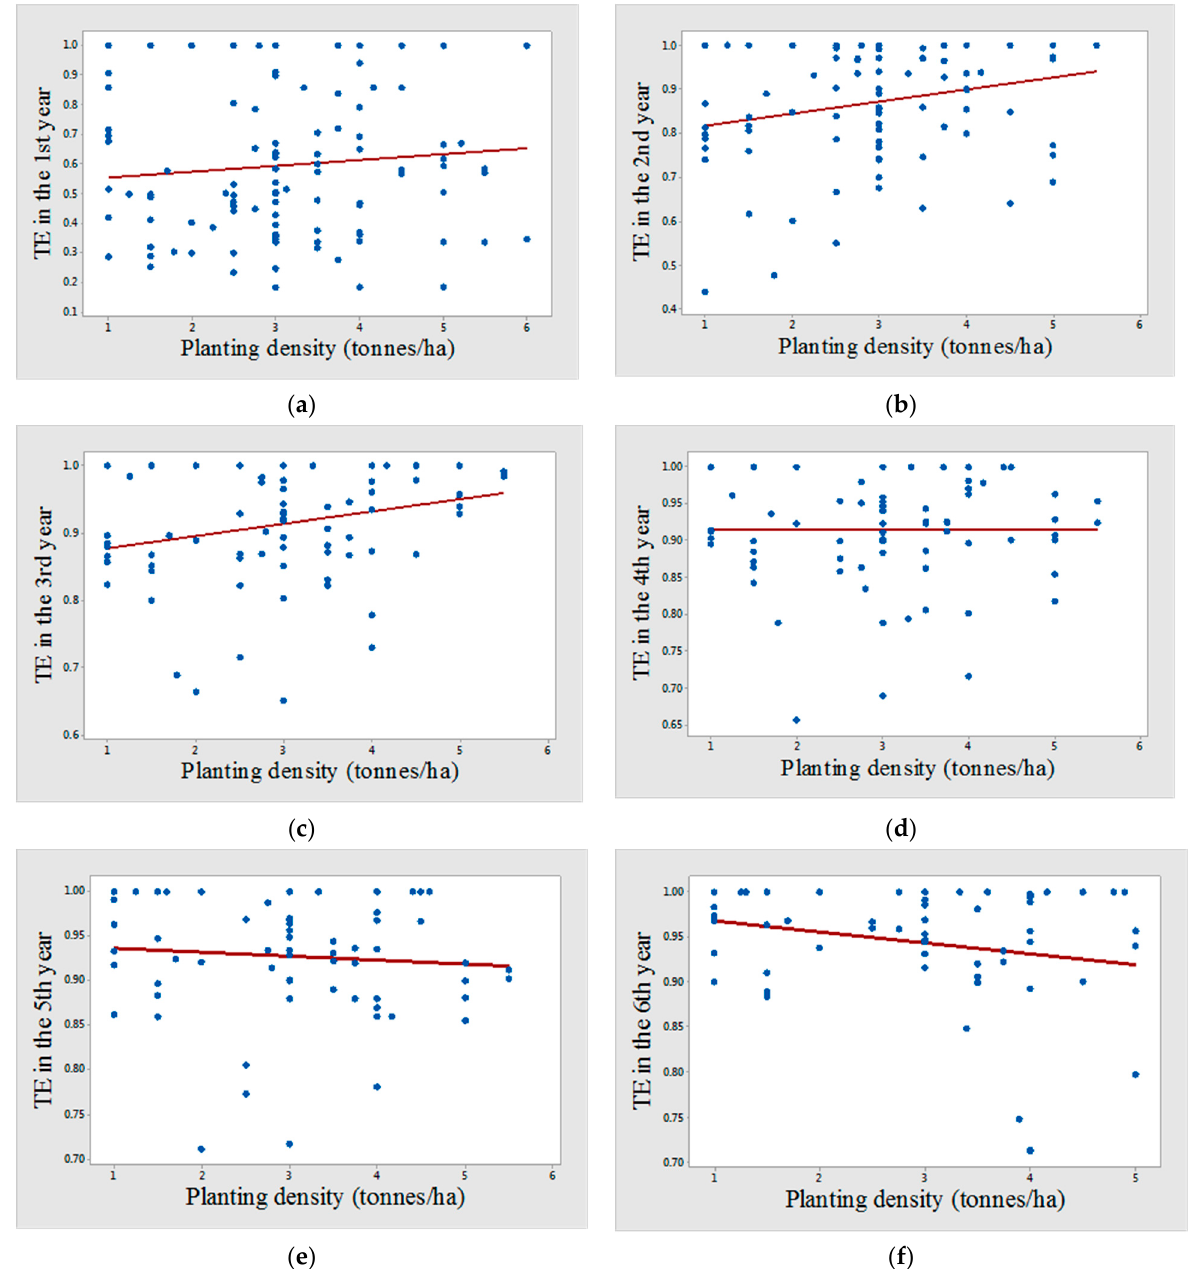
Figure 3. Panels ( a – f ) depict the relationship between corm planting density and technical efficiency in the first six years of farm